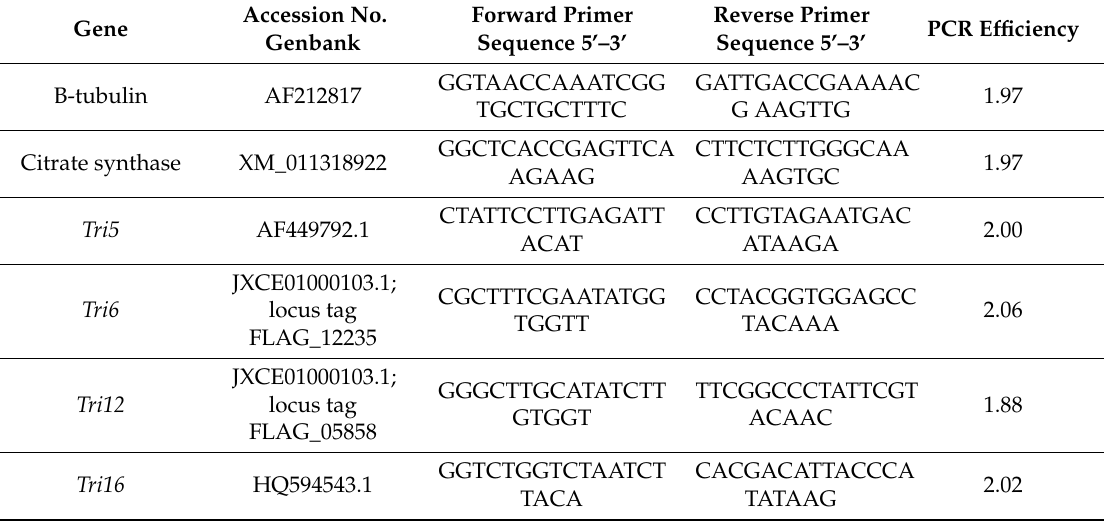
Table 3. Studied genes, primers used for qPCR analysis and PCR